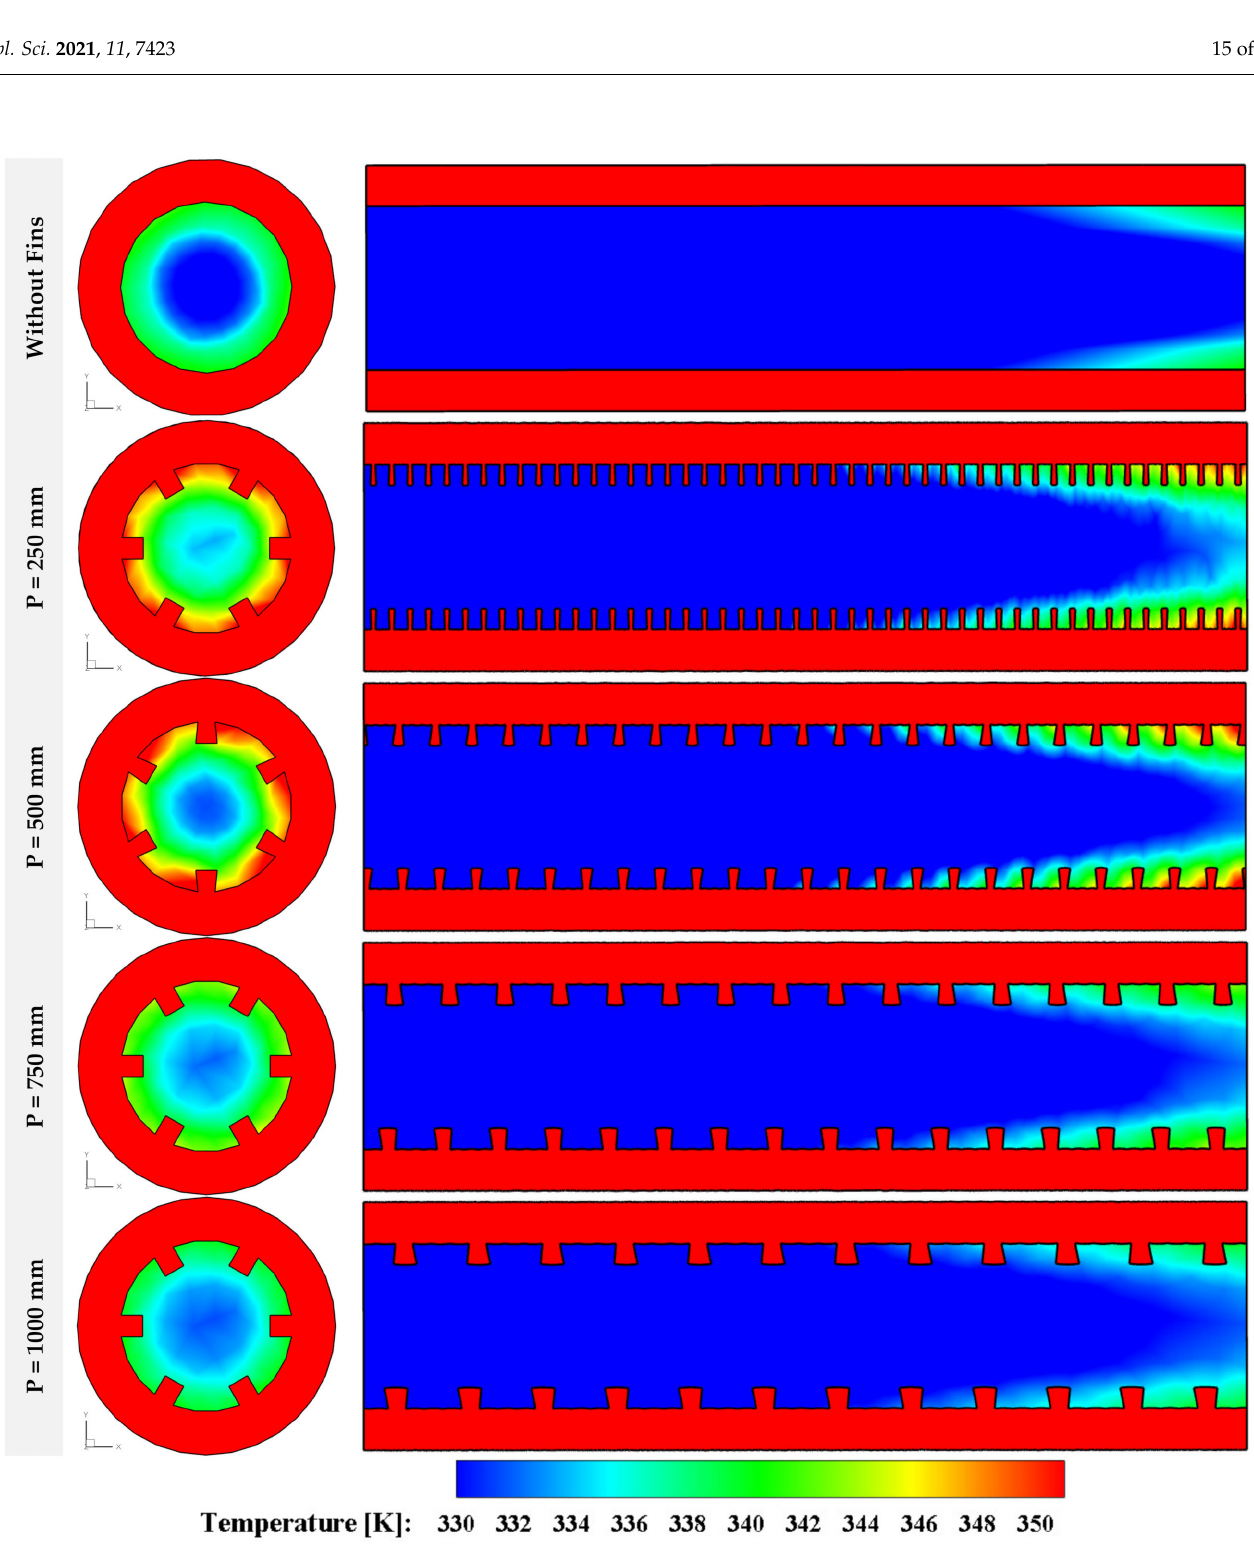
Figure 14. Contours of temperature at outlet and a slice (X = 0) for various models at V Inlet = 0.1256